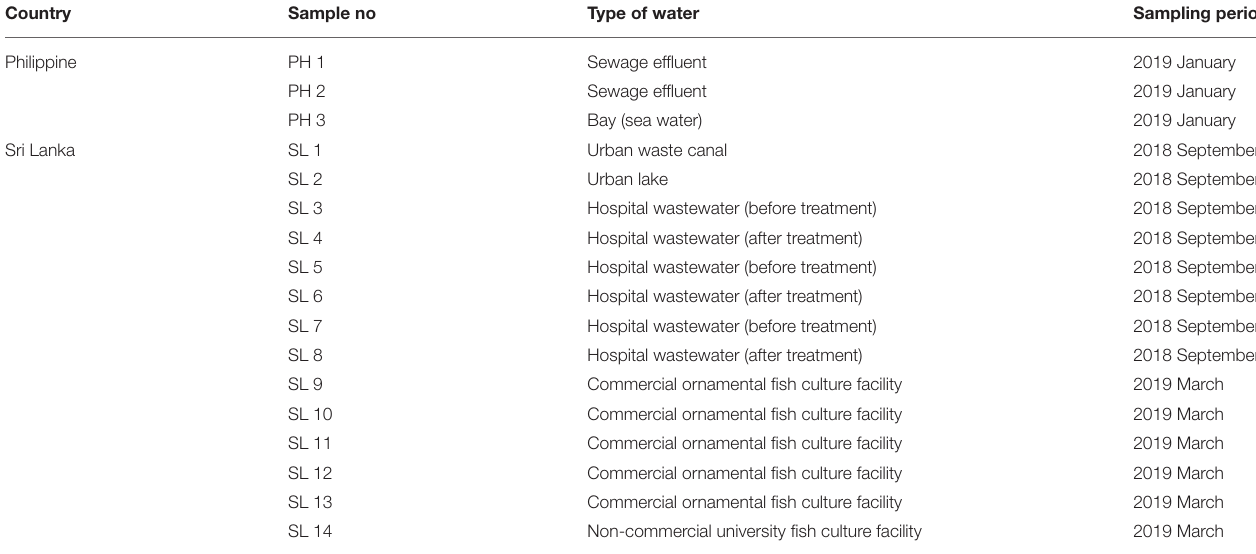
TABLE 1 | Details of